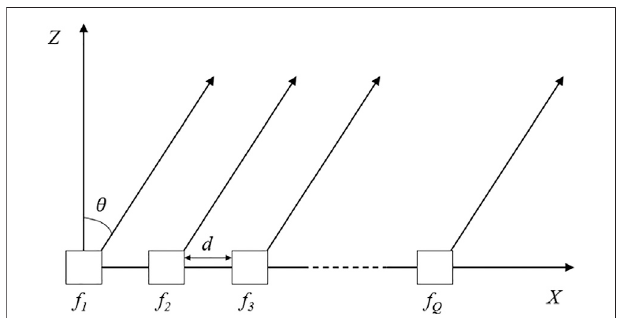
FIGURE 1 | Q — element linear Frequency Diverse